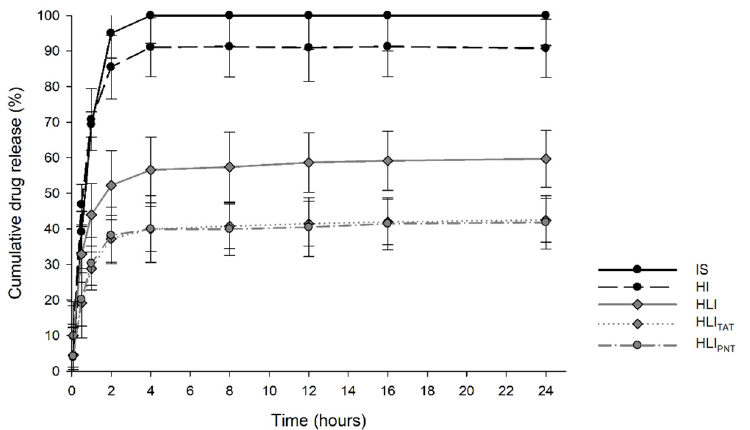
Figure 2. In vitro release profile of insulin by formulations in 24 h. Insulin solution (IS); HEC-based hydrogel containing insulin (HI); HEC-based hydrogel containing insulin-loaded liposomes (HLI); HEC-based hydrogel containing insulin-loaded liposomes functionalized with TAT (HLI TAT ); HEC-based hydrogel containing insulin-loaded liposomes functionalized with PNT (HLI PNT ).